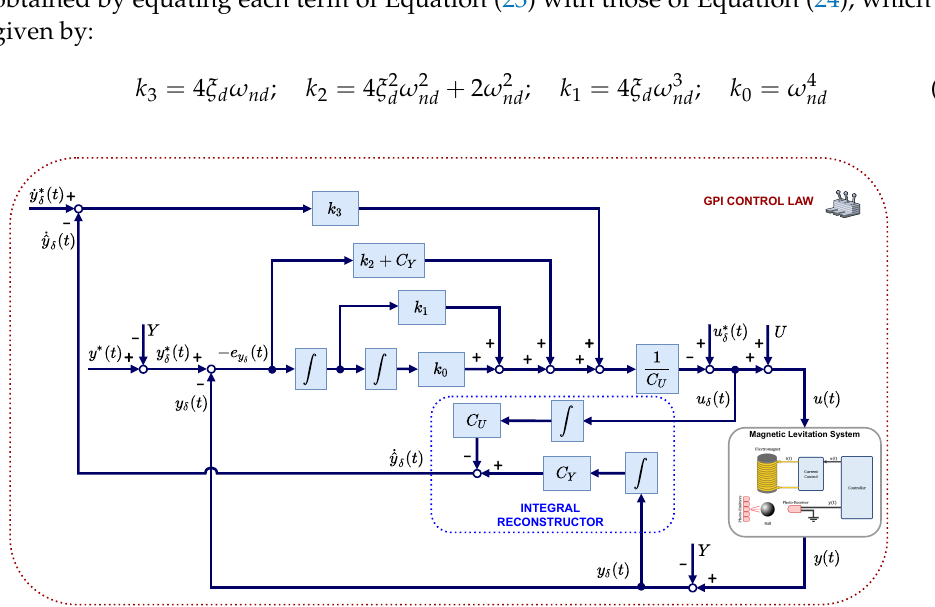
Figure 2. GPI control